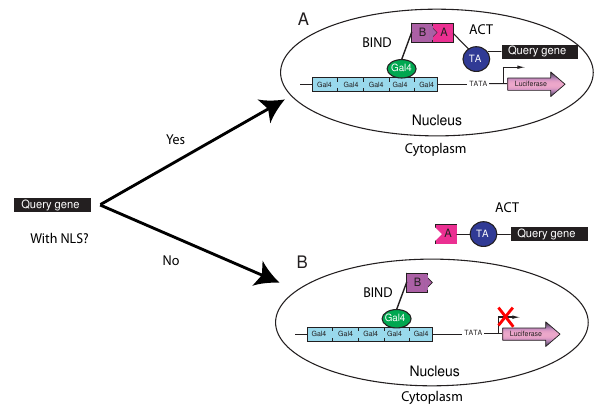
Figure 1 Schematic representation of the system . The pG5 luc vector contains five GAL4-DNA binding domains upstream of a minimal TATA box, which in turn is upstream of the firefly luciferase gene. Box A and B are the interacting partners in ACT and BIND construct, respectively. Box TA in the ACT construct is a transcriptional activation domain. (A) If the tar- get gene contains a NLS, the ACT construct product can translocate into the nucleus and interact with the BIND con- struct product, which activates the luciferase reporter gene. (B) If the target gene does not contain any coding sequence for NLSs, then the ACT construct product can not enter the nucleus and the luciferase gene remains